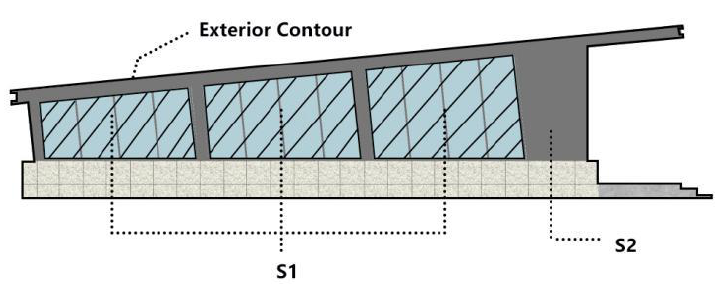
Figure 3. Schematic diagram of exterior contour and relative area of façade windows.